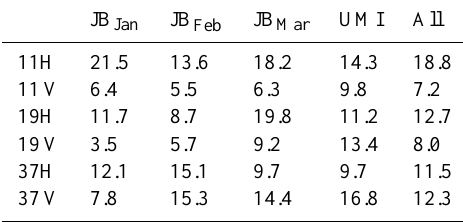
Table 7. Overall RMSEs (K) between measured and simulated T B for all sites considering ice lenses and bridging in